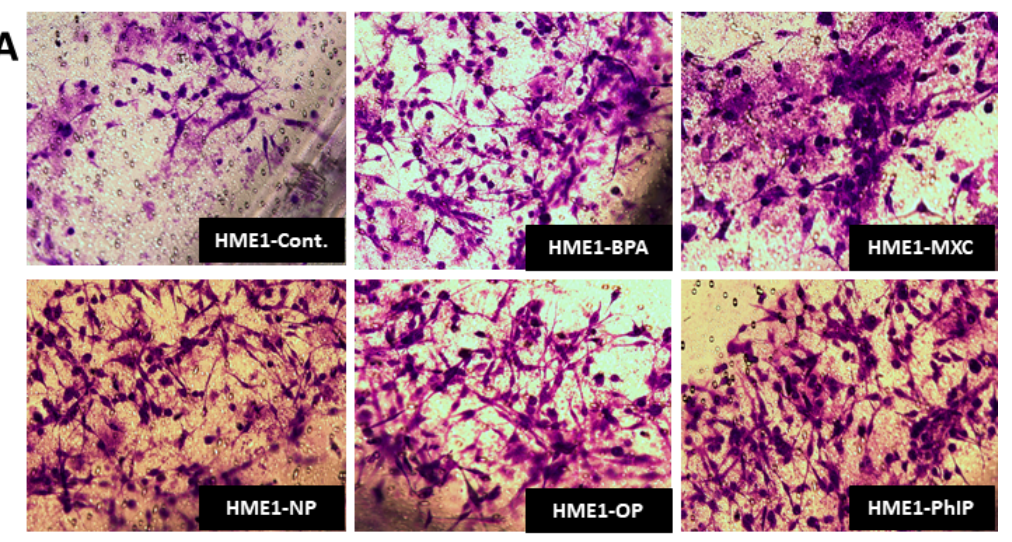
Figure 3. Collagen invasion assay of mammary epithelial cell (HME1) cell line exposed to various chemicals as compared to the base line invasion of control (vehicle-exposed) HME1 cell line. Cells were treated with nanomolar concentrations (BPA, MXC, HBCD, NP, OP, and PhIP at 0.0043, 0.0028, 0.0015, 0.0045, 0.0048, and 0.0044 nM, respectively) for two months then cells were serum starved and tested for their ability to invade through college-coated membrane using Boyden chambers. Invaded cells were fixed, stained, and visualized under the microscope and then the dye was eluted and measured using a plate reader. ( A ) Representative figures to show the differences in invasion potential as detected by microscopic examination. ( B ) quantitative evaluation of cell invasion as measured by dye elution and spectrophotometric reading at 560 nm. Mean ± SEM, * p < 0.05, n = 3. 2.6. Colony Formation in Soft Agar. Cell Transformation Detection Assay is an anchorage-independent growth assay in soft agar, which is considered the most stringent assay for detecting malignant transformation of cells. This experiment was performed on the 2-months-exposed cells. Some toxic agents showed increased colony formation above the control level in MCF7 cell lines Figure S3, however, none of the HME1 stocks formed colonies in soft agar under the test conditions. 2.7. Proteomic Analysis (Human Phospho Kinase Array) In HME1 there was significant increase in 6 phosphoproteins: Epidermal growth factor receptor (EGFR), cyclic AMP response element binding protein (CREB), the signal transducer and activator of transcription 6 (STAT6), c-Jun, STAT3, and heat shock protein 60 (HSP60); and considerable increase in some others such as heat shock protein 27 (HSP27), 5′-AMP-activated protein kinase catalytic